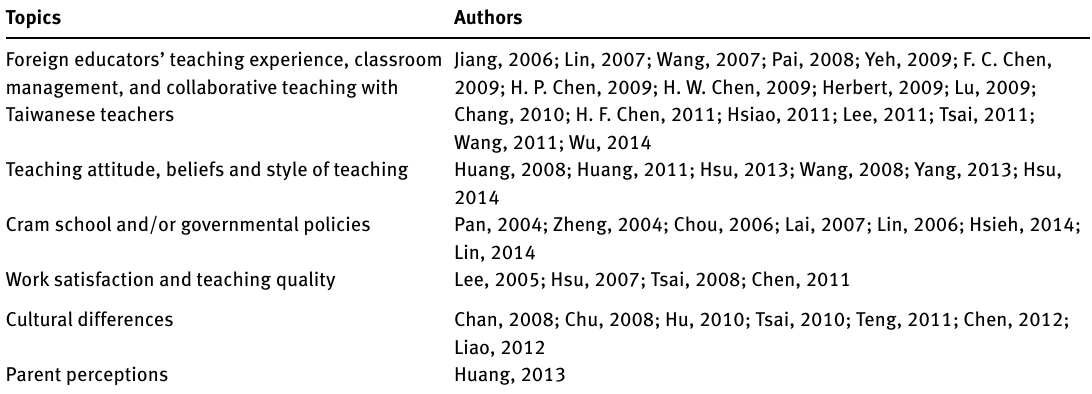
Table 1: Relevant Theses in Taiwan (2004-2014) (compiled by the author) Topics